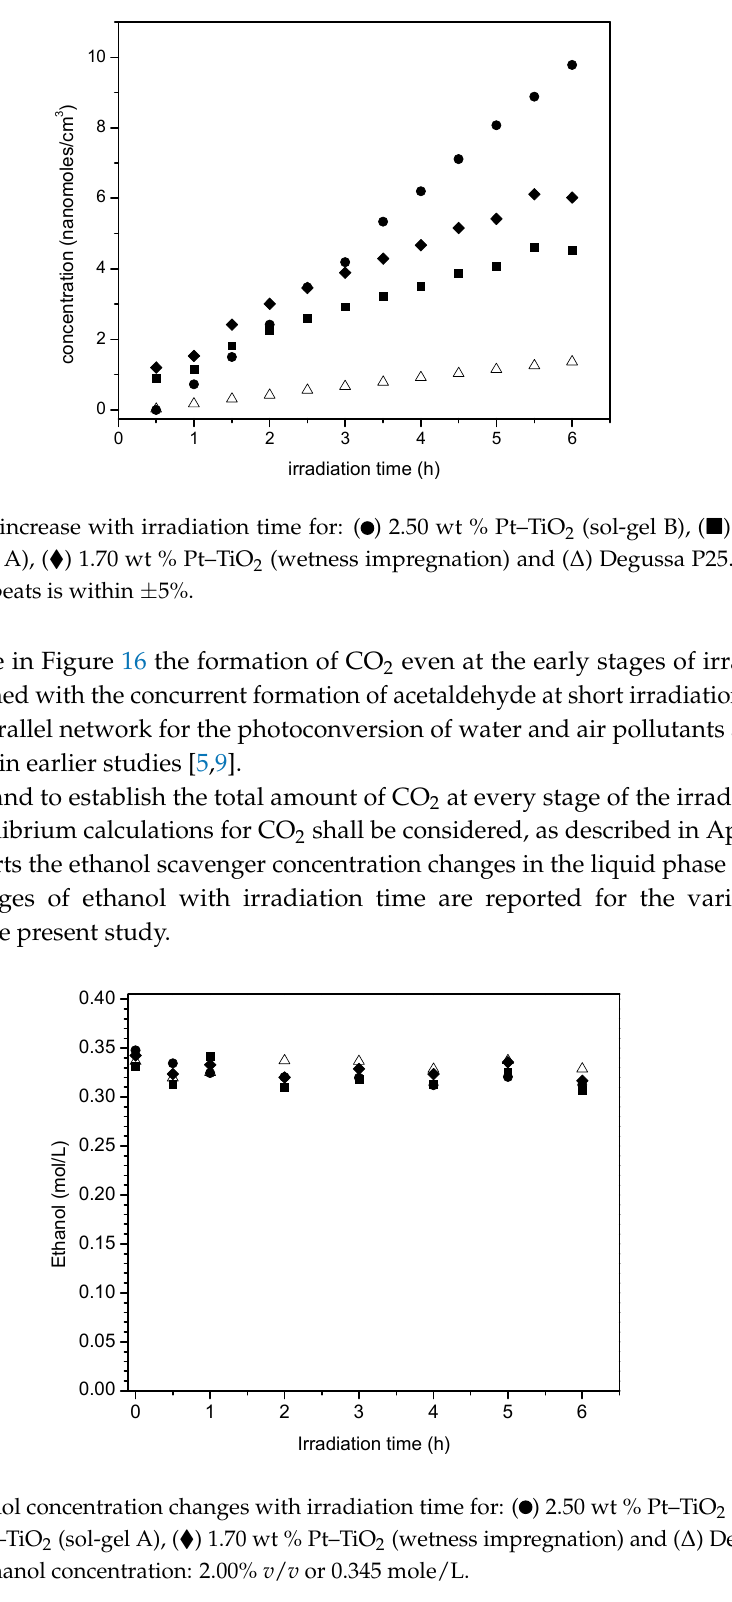
irradiation time (h) Figure 15. Acetaldehyde increase with irradiation time: ( ● ) 2.50 wt. % Pt–TiO 2 (sol-gel B), ( ■ ) 1.70 wt. % Pt–TiO 2 (sol-gel A), ( ♦ ) 1.70 wt. % Pt–TiO 2 (wetness impregnation) and ( ∆ ) Degussa P25. Standard deviation for repeats was within ±5%.